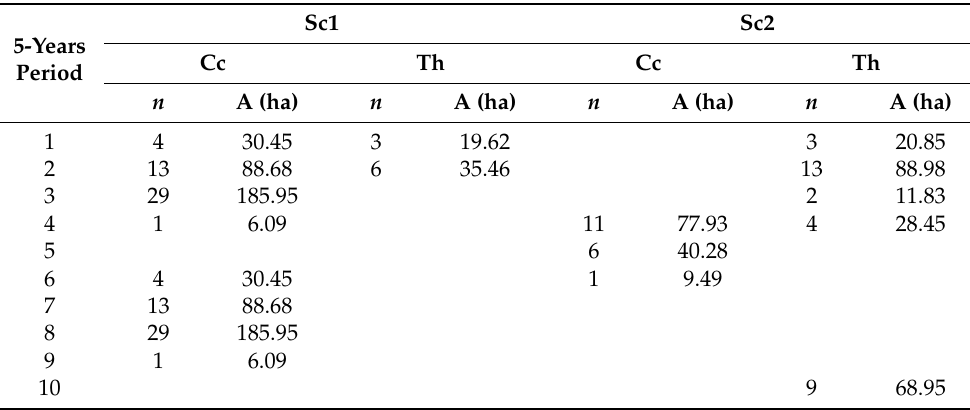
Table 4. Characterization of FMO results according to the optimal solution during the planning horizon, discriminated by scenario.